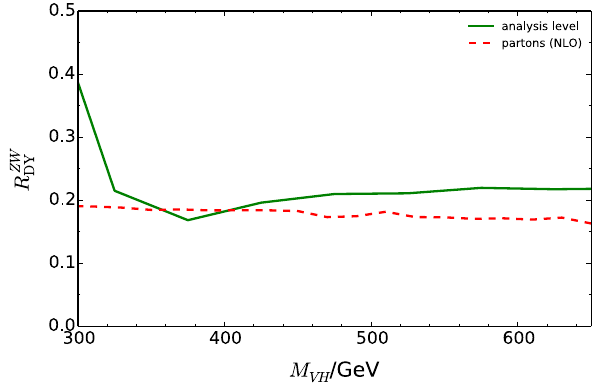
Fig. 8 Comparison of the hadron-level prediction of the ratio of DY- like ZH -productionto WH -production, R ZW (The curves in this plot include the branching ratios of the Z and the W